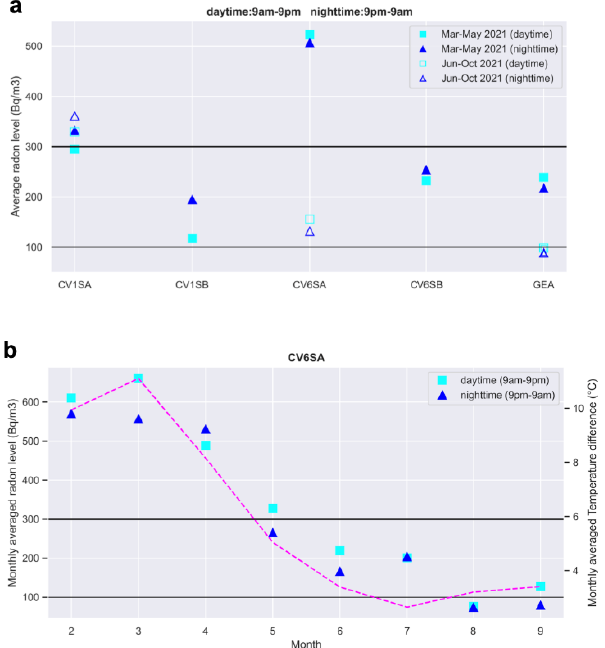
Figure 9. ( a ) Average radon concentration computed over the day and night intervals during the month’s March–May 2021 (5 instruments) and June–October 2021, when only three instruments kept working. ( b ) Monthly averaged radon concentration at station CV6SA computed over the day and night intervals. The dashed line indicates the monthly average of the indoor-outdoor temperature difference. Black lines refer to the reference levels of 300 (thick) and 100 (thin) Bq/m 3 .